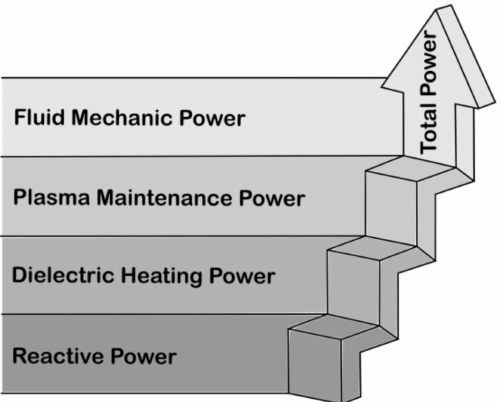
Figure 7. Power-flow diagram of a dielectric barrier